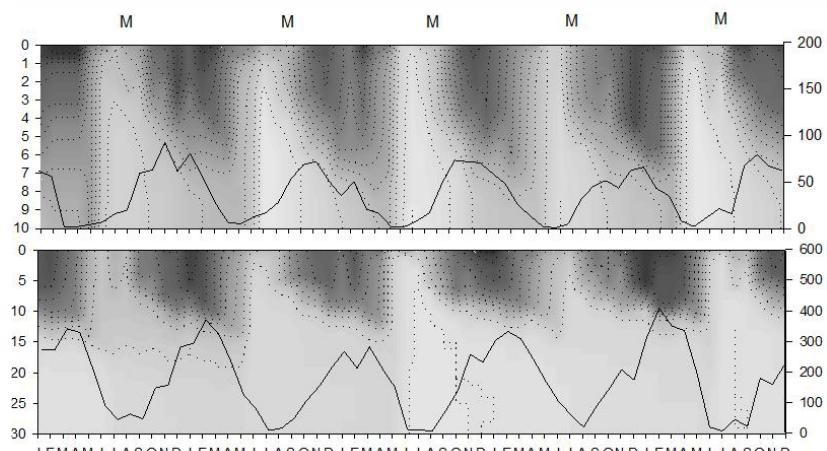
Figure 2. Depth-time diagram of water temperature (ºC) and thermal stability (filled line; g cm cm -2 ) over 5 years (2002-2006) in lakes Carioca (above) and Dom Helvécio (below), Rio Doce State Park, southeast Brazil (M: mixing